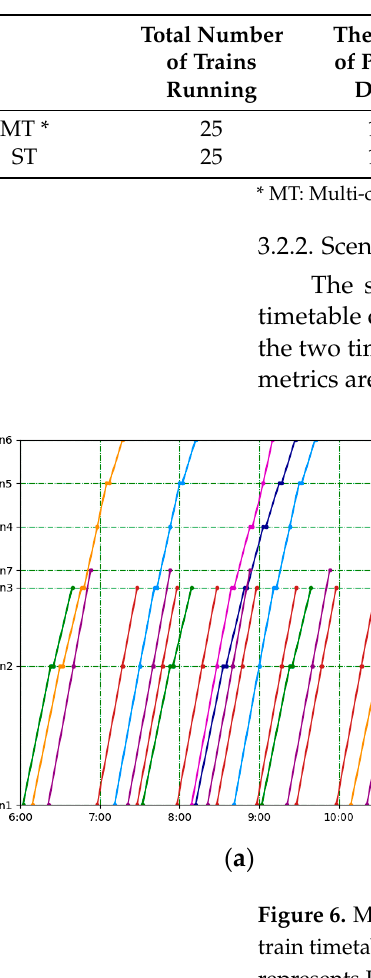
Figure 7. Supply and demand matching diagram under scenario 2. ( a ) Supply and demand matching diagram of multi-cycle train timetable. ( b ) Supply and demand matching diagram of sin- gle-cycle train timetable.